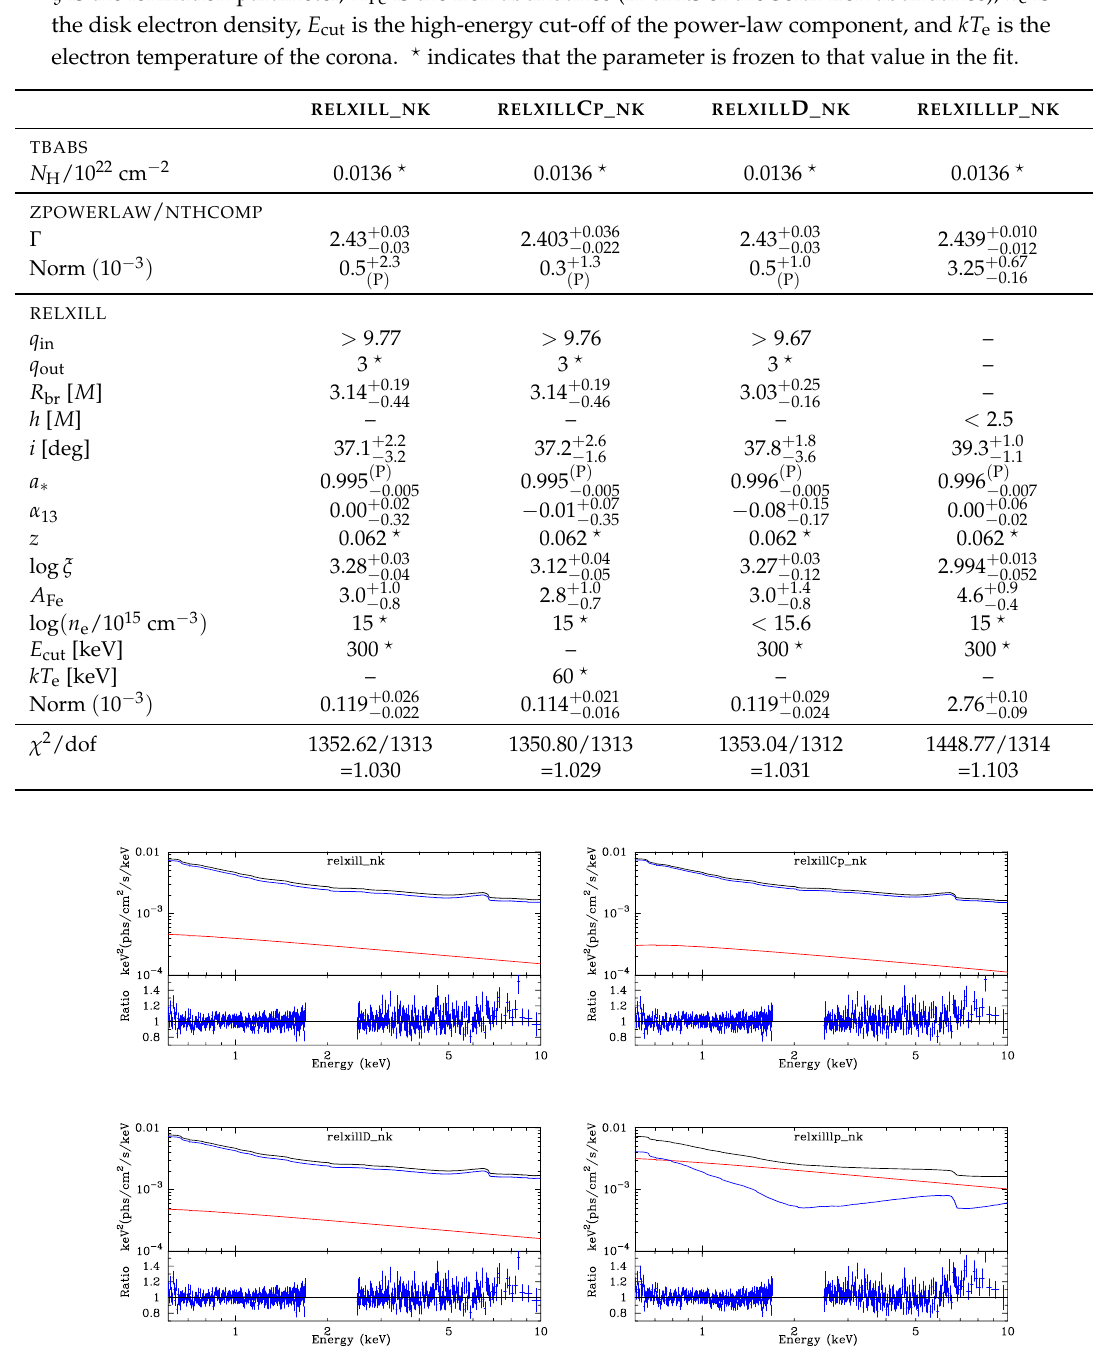
Figure A1. Spectra of the best fit models with the corresponding components ( upper panels ) and data to best-fit model ratios ( lower panels ) for Ton S180 when the reflection component is modeled by RELXILL _ NK ( top left panel ), RELXILL C P _ NK ( top right panel ), RELXILL D_ NK ( bottom left panel ), and RELXILLLP _ NK ( bottom right panel ). The total spectra are in black, power law components from the coronas are in red, and the relativistic reflection components from the disk are in